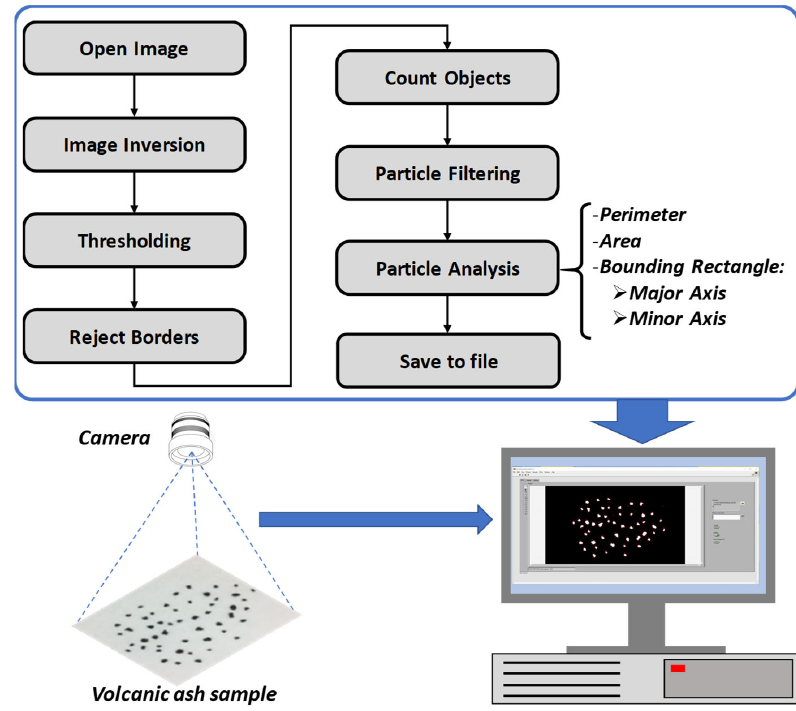
Figure 1. The image processing paradigm.